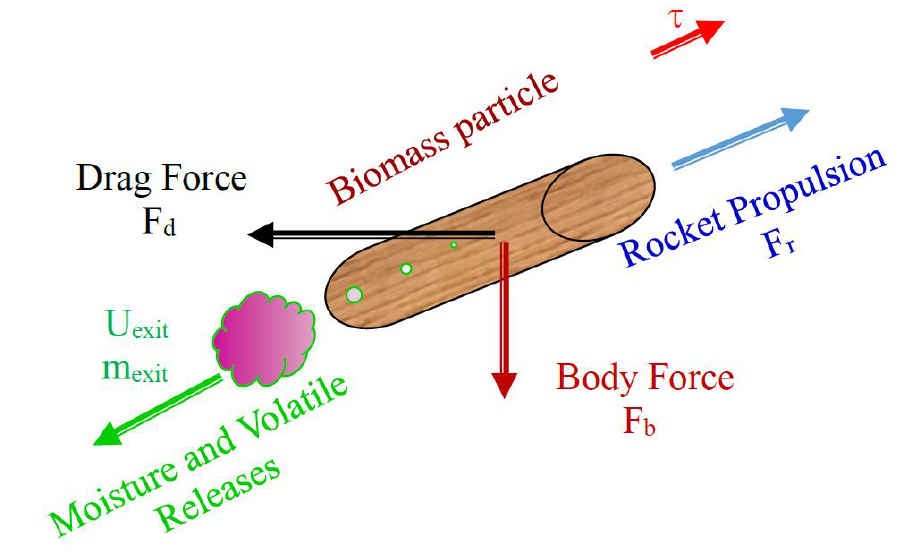
Figure 1. Schematic view of biomass particle and effect forces with moisture and volatile releases from one end and rocket propulsion on the opposite end.